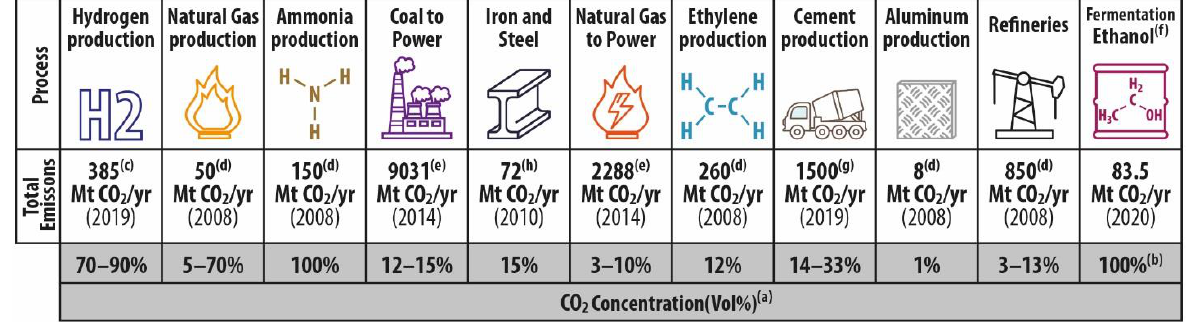
Figure 1. Industrial process emissions (Mt CO 2 /year) and CO 2 content (vol.%) from different industries: (a) [14], (b) [15], (c) [16], (d) [17], (e) [18], (g) [19], (h) [20], (f) ethanol (fermentation) emissions calculated using emission factor of 6.29 lbs CO 2 /gallon ethanol [21] and ethanol production data [22].